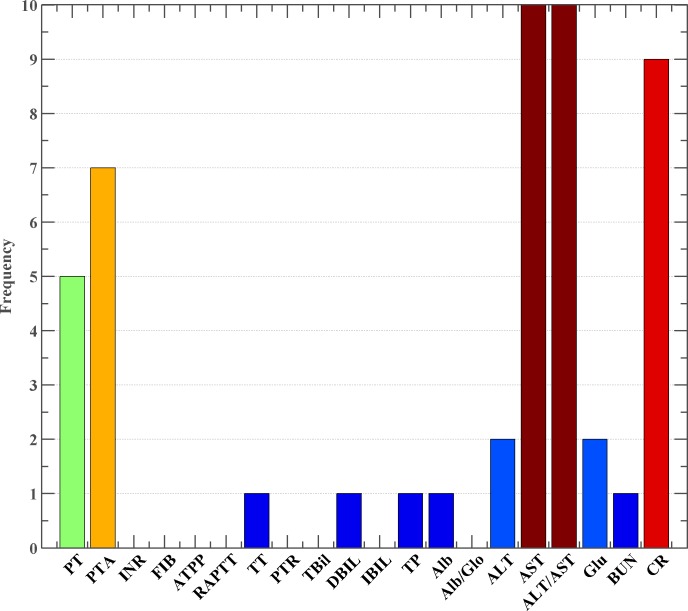
The frequency of selected features in 10-fold CV.